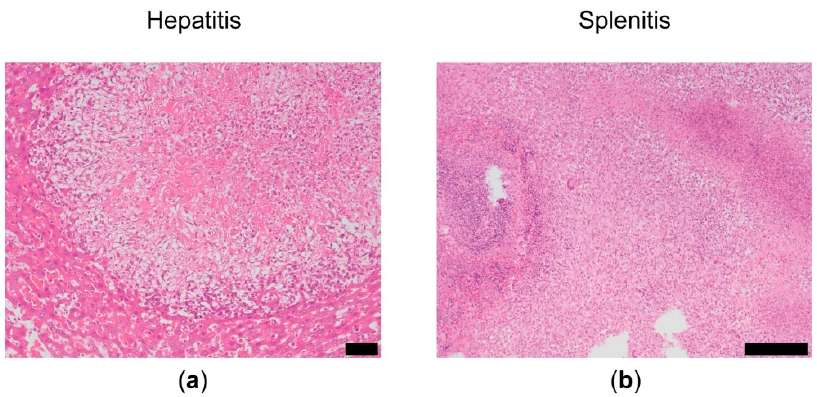
Figure 1. Microscopic overview of ( a) liver and ( b) spleen after the initial priming and the three reactivations that indicate signs of hepatitis and splenitis. Scale bar left panel 50 µm and right panel 100